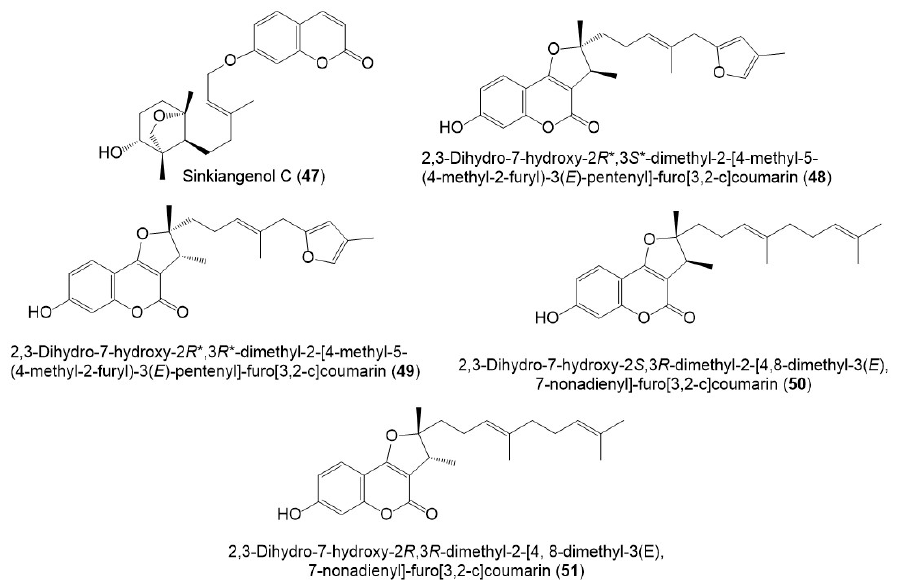
Figure 7. Structures of sesquiterpene coumarins ( 47 – 51 ) reported from F. sinkiangensis .